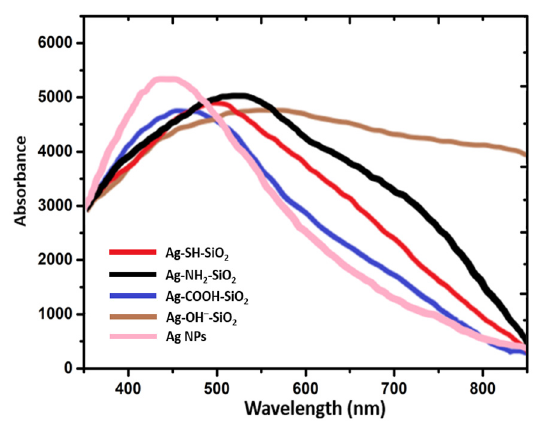
Figure 7. Ultraviolet (UV) − visible absorption spectra of different Ag-modifier-SiO 2 , the dispersed Ag NPs included for comparison.